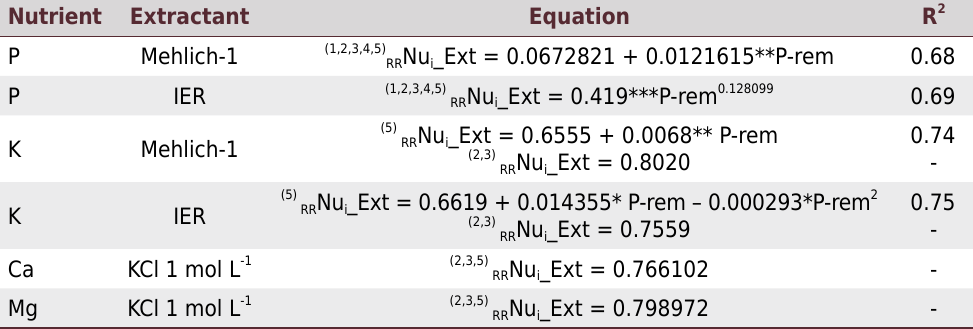
Table 1. Equations to estimate the rate of recovery by the extractant for P, K, Ca, and Mg applied to the soil through fertilizers [ RR Nu i _Ext, in (mg dm -3 )/(mg dm -3 )], which varies, or not, with remaining P (P-rem, in mg L -1 )